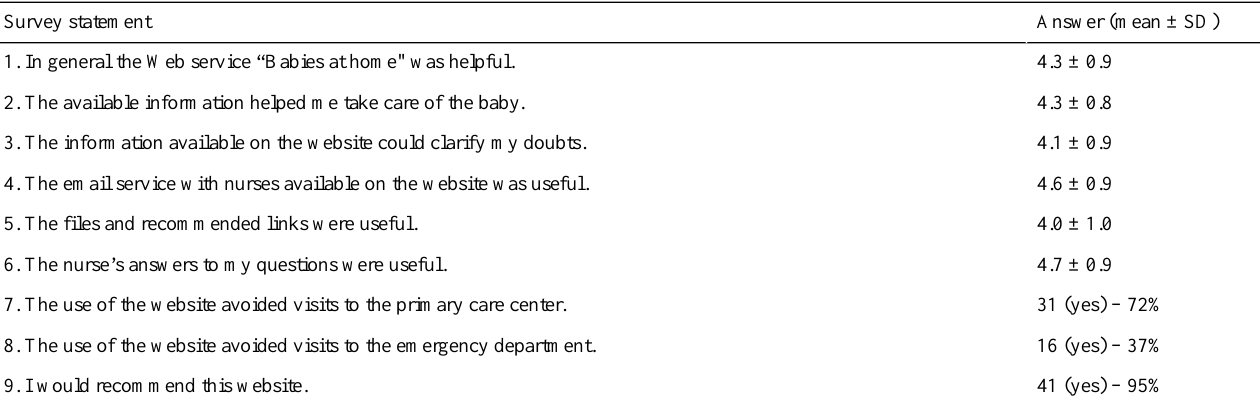
Table 2. Results of patients’satisfaction survey (mean ± SD) where 0 means “I strongly disagree” and 5 means “I strongly